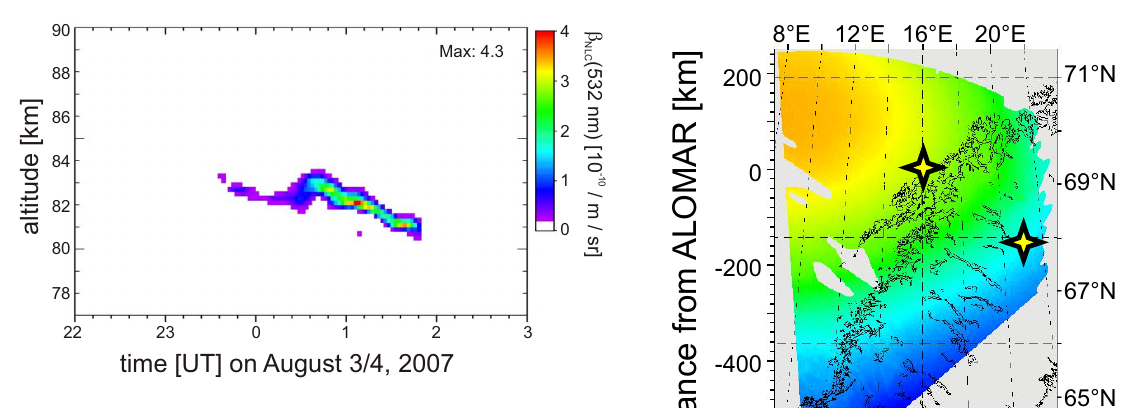
Fig. 6. Temporal evolution of the noctilucent cloud above the IAP (54 ◦ N) on 3/4 August 2007 as measured by the RMR-lidar. The peak backscattering of 4.3 × 10 − 10 m − 1 sr − 1 was reached about 01:00UT.